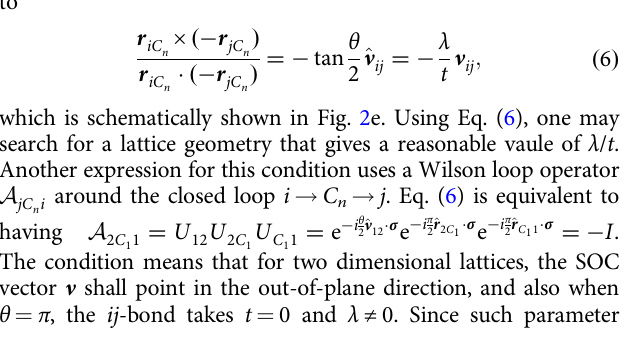
Fig. 2 Spinor line graph theory. a Pyrochlore lattice and its dual diamond lattice ( C j ) in the red circle. The two lattices are connected and form a bipartite graph on the right panel. b Kagome and its dual honeycomb lattice, where ν ij = (0, 0, ±1). Noninteracting band structures for λ / t = 0 to shown. c Unit tetrahedron. Hopping 1 → 2 rotates the spin orientation by θ about the ν 21 -axis, whereas hopping through 1 → C 1 → 2 rotates the spin orientation twice by π each about the r C axes for site-1 and 2 in Fig. 1a. Here, j r C 1 → C 1 vector when taking the length of the cell as unity. d Example of spin rotation along two paths that ful fi ll Eq. (5). e Condition to have SOC fl at band in Eq.